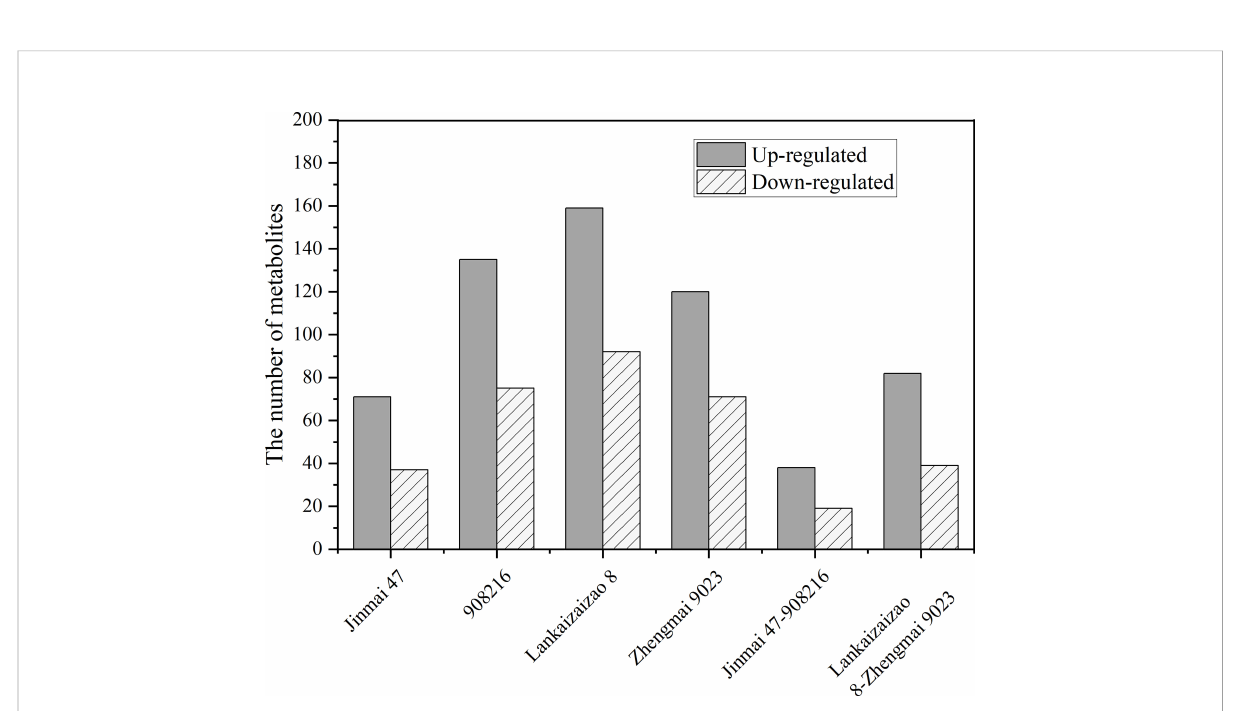
FIGURE 5 The number of signi fi cantly up-regulated or down-regulated metabolites under drought stress in the four genotypes Jinmai 47, 908216, Lankaoaizao 8, and Zhengmai 9023 respectively, as well as that in the two drought tolerant dryland genotypes Jinamai 47 and 908216 in common, and that in the two drought sensitive irrigated genotypes Lankaoaizao 8 and Zhengmai 9023 in common.